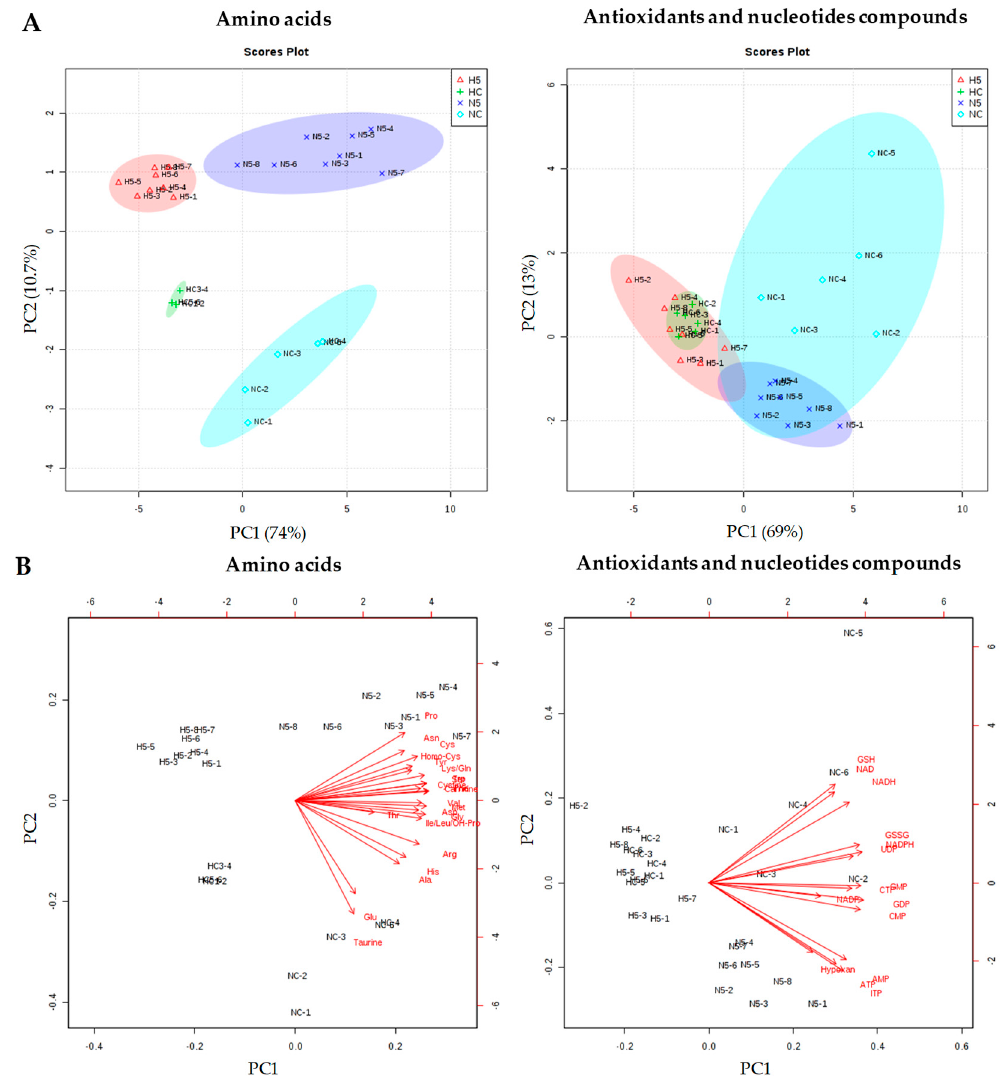
Figure 4. ( A ) PCA scores and ( B ) eigenvector plots for the amino acids, antioxidants, and nucleotides compounds, according to the metabolites found to differ significantly (ANOVA p < 0.05) among the different diets: group NC: standard diet, N5: standard diet + 5% spinach, HC: high fat diet and H5: high fat diet + 5% spinach. Confidence regions are marked with different ellipses.